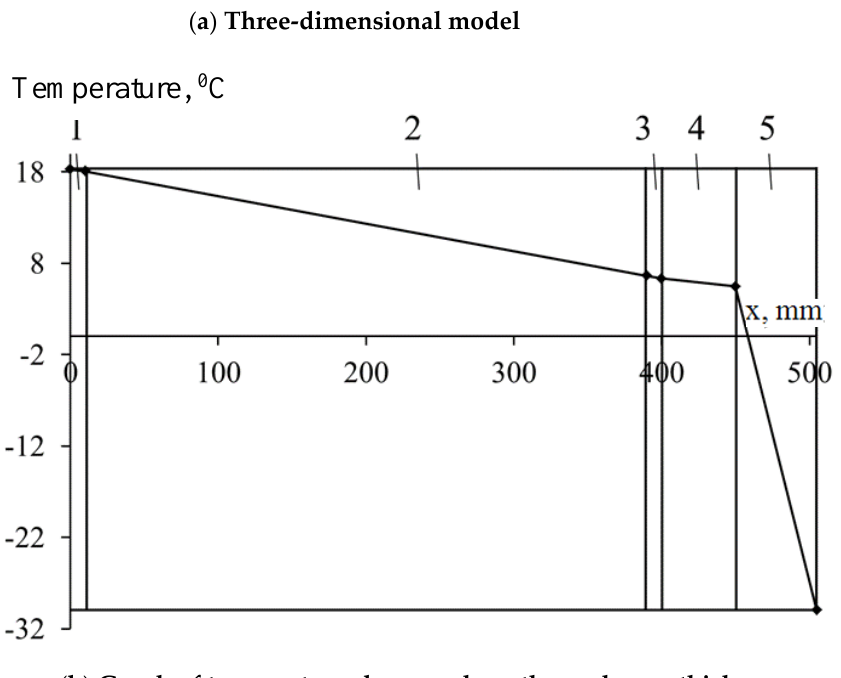
Figure 14. Temperature field in the enclosure at the absolute minimum ambient temperature: ( a ) — three-dimensional model; ( b ) — graph of temperature changes along the enclosure thickness in the cross section of the air channel: 1, 3 — cement-sand plaster; 2 — bearing layer from ceramic brick; 4 — closed air channel; 5 — insulant — extruded polystyrene foam.